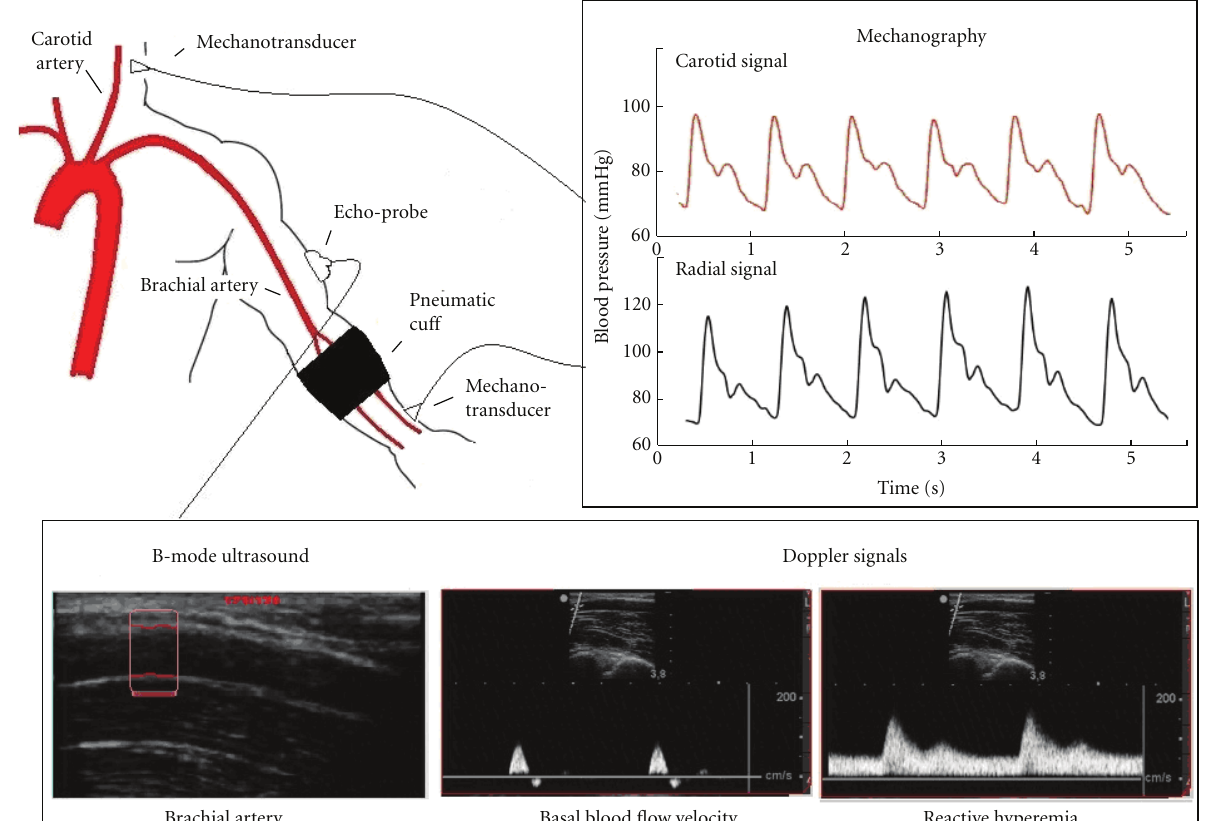
Figure 1: Schema of the instrumental approach employed to measure the PWV cr and SI (mechanotransducers), brachial artery diameter (B- mode ultrasound), and blood flow velocity (Doppler signals). Note the carotid and radial pulse pressure (mechanography), the longitudinal view of the brachial artery (B-mode ultrasound), and the brachial blood flow velocity (Doppler signals) before and after the cu ff occlusion and deflation were performed. Immediately after the cu ff deflation, there is an acute and transient increase in brachial blood flow velocity